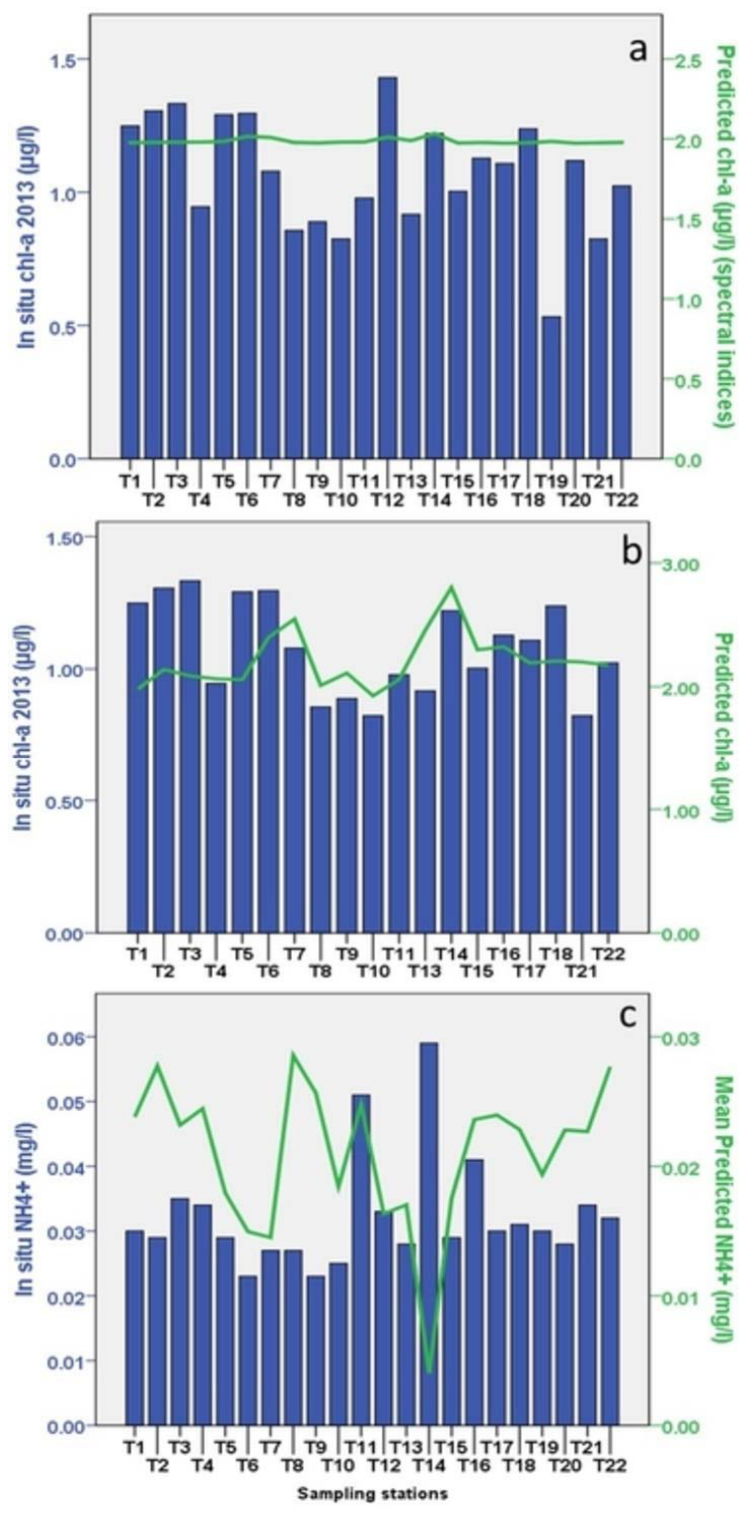
Figure 9. Dual axes line ‐ bar charts illustrating the under study (in ‐ situ and satellite derived) parameters’ distribution, as resulted from the validation models, e.g., ( a ). Chlorophyll ‐ a (in ‐ situ and satellite derived based on spectral indices), ( b ) Chlorophyll ‐ a (in ‐ situ and satellite derived based on spectral L8 bands) and ( c ) NH 4+ concentrations.